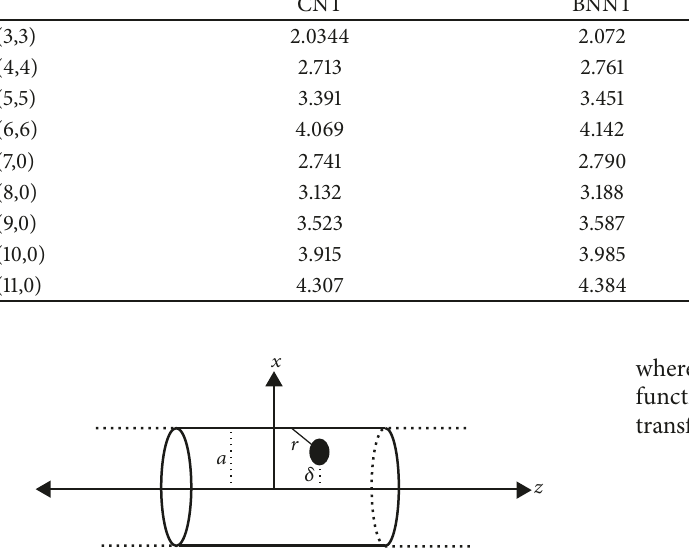
Figure 3: Schematic illustration of an offset Ni atom inside a single- walled